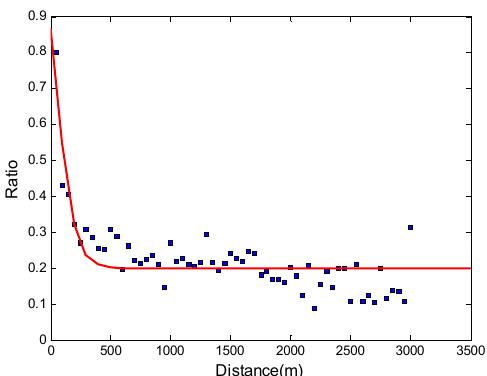
Figure 10. Ratio distribution of the pine forests injured relatively seriously in different distance class with the pine forests severely damaged (NDII5 < 0.1) in last year. The abscissa was the distance class and the ordinate was the ratio of points (1500 points with less NDII5 in all 5015 sample points) on the pine forests damaged relatively more seriously to all points.